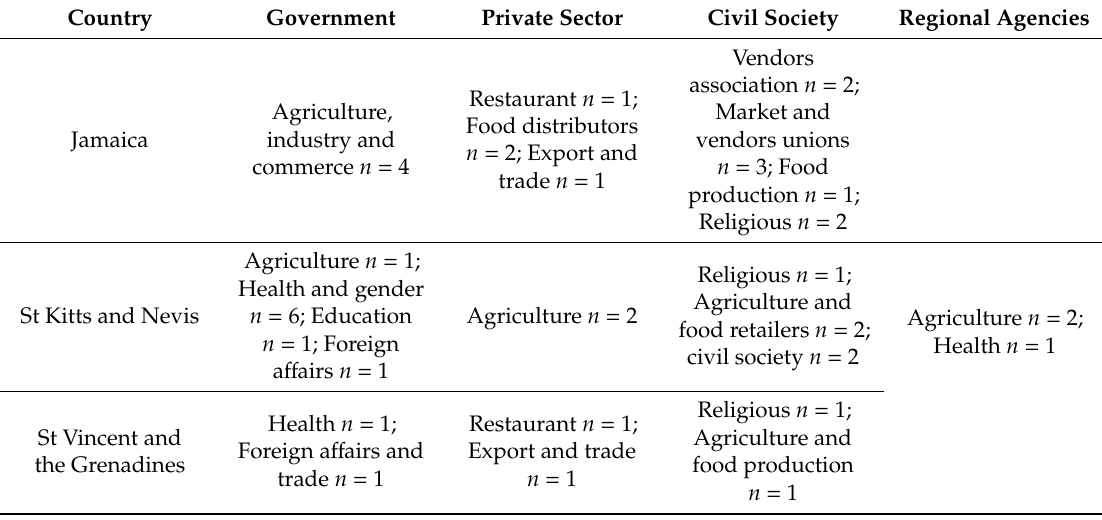
Table 2. Number of stakeholders across sectors participating in the group model building workshops.